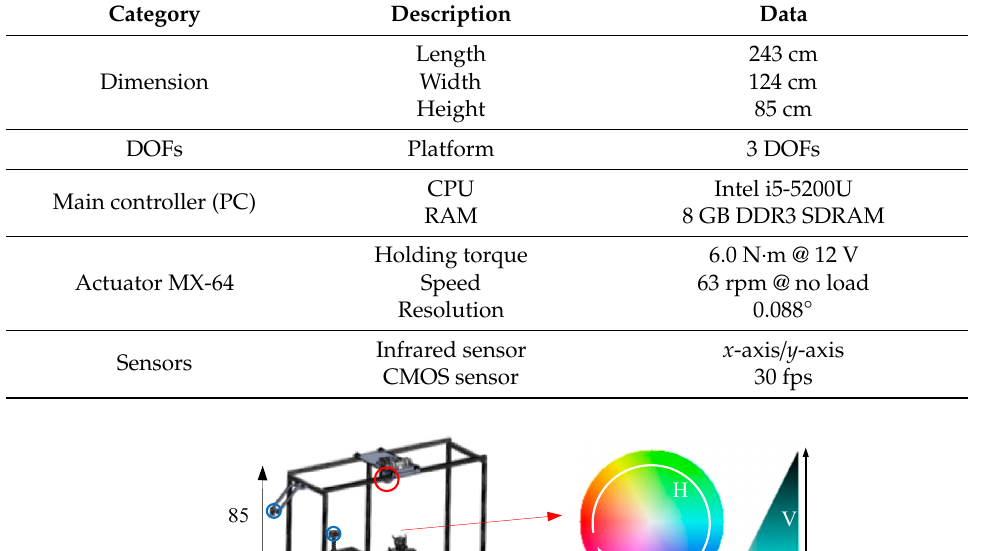
Table 2. Specifications of the automatic training platform.